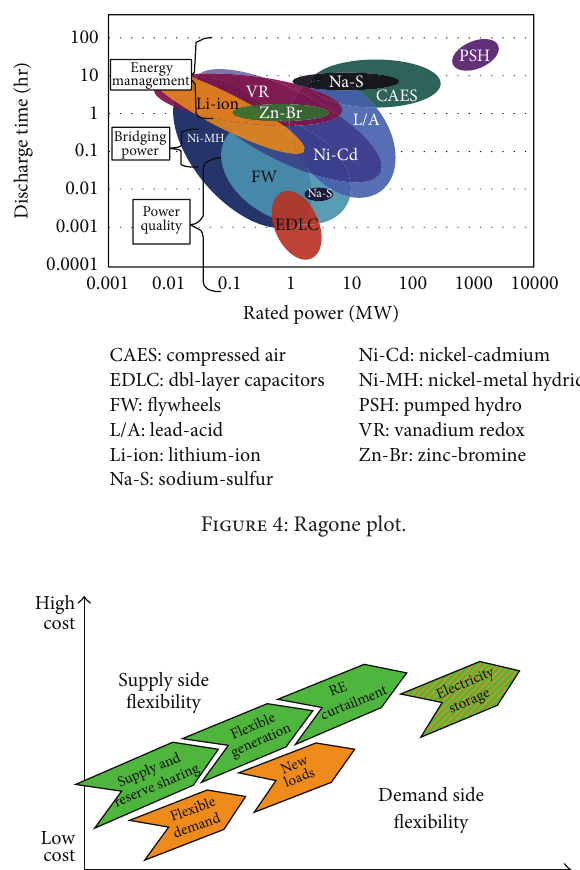
Figure 5: Different options for incorporating greater amount of renewable energy into the